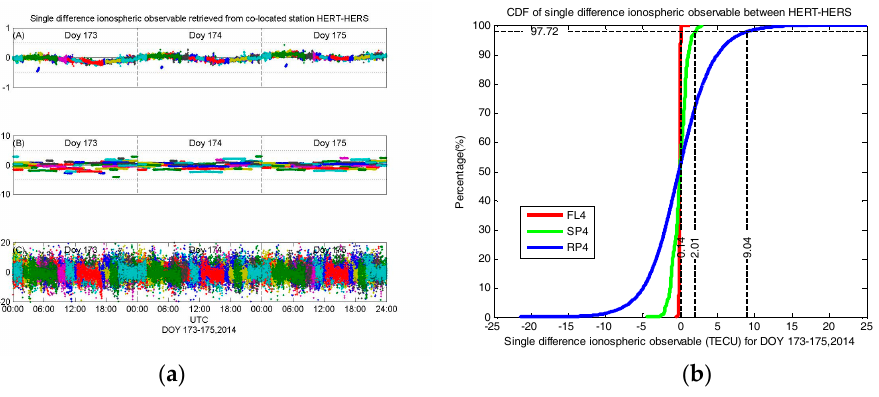
Figure 1. Single difference ionospheric observable retrieved from co-located station HERT-HERS from DOY 173 to 175, 2014, using ( A ) FL4 ( B ) SP4 ( C ) RP4 observable ( a ) and the cumulative distribution function (CDF) of single difference FL4, SP4 and RP4 observable (after removing the mean value, see Table 5) from the co-located station HERT-HERS ( b ).